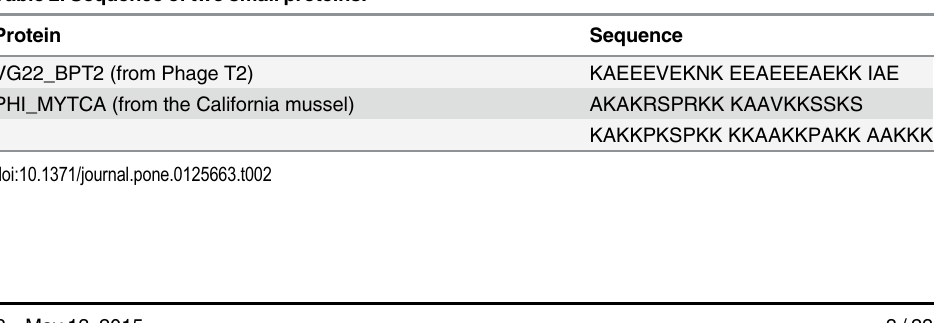
Table 2. Sequence of two small